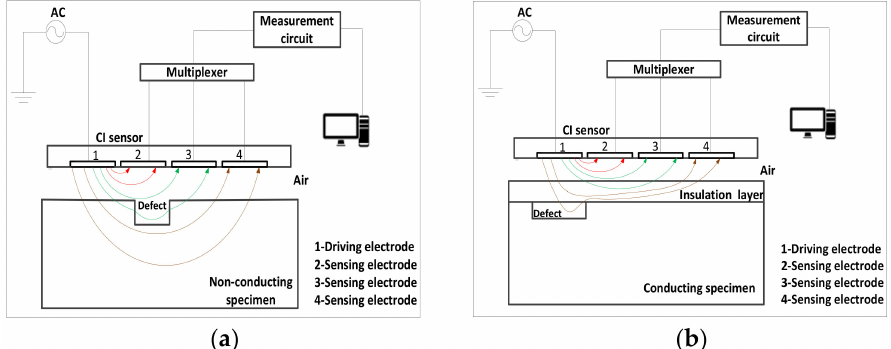
Figure 2. Detection principle of the multi-electrode sensor: ( a ) the multi-electrode sensor inspecting the non-conducting specimen; ( b ) the multi-electrode sensor inspecting the conducting specimen covered by an insulation